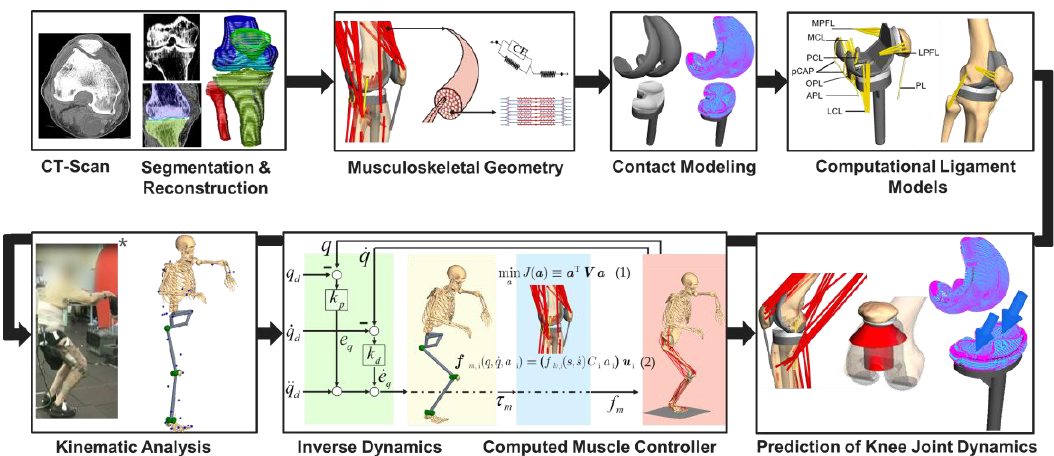
Figure 1. Workflow for generating the musculoskeletal multibody simulation model of the lower extremity with a total knee replacement. The illustration marked with * was taken from [57]. Permission to publish is granted under a CC BY open access